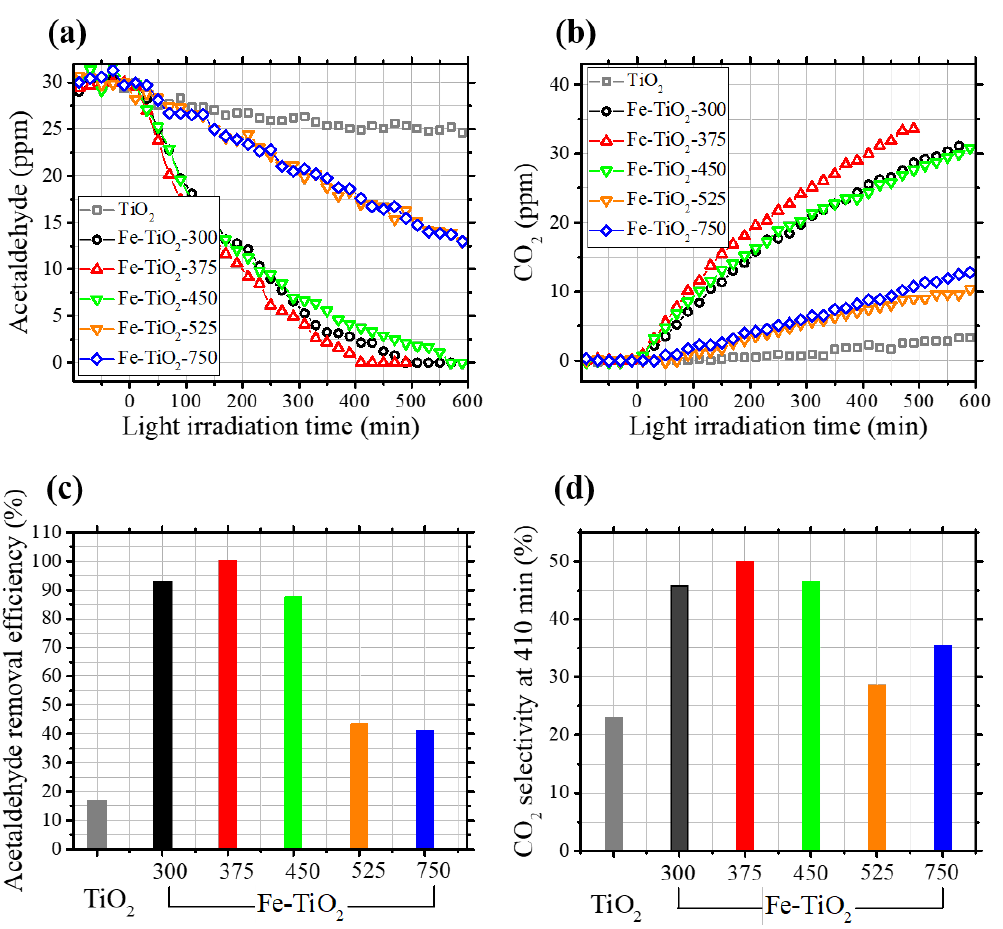
Figure 2. Results of the photocatalysis experiments. Concentration changes of ( a ) acetaldehyde and ( b ) CO 2 as a function of the visible light irradiation time in the presence of as-received TiO 2 (TiO 2 ) and five different Fe-TiO 2 samples (Fe-TiO 2 -300, -375, -450, -525, and -750). ( c ) Removal efficiencies for acetaldehyde and ( d ) CO 2 selectivity determined after 410 min of visible light irradiation in the presence of TiO 2 and Fe-TiO 2 -300, -375, -450, -525, and -750.